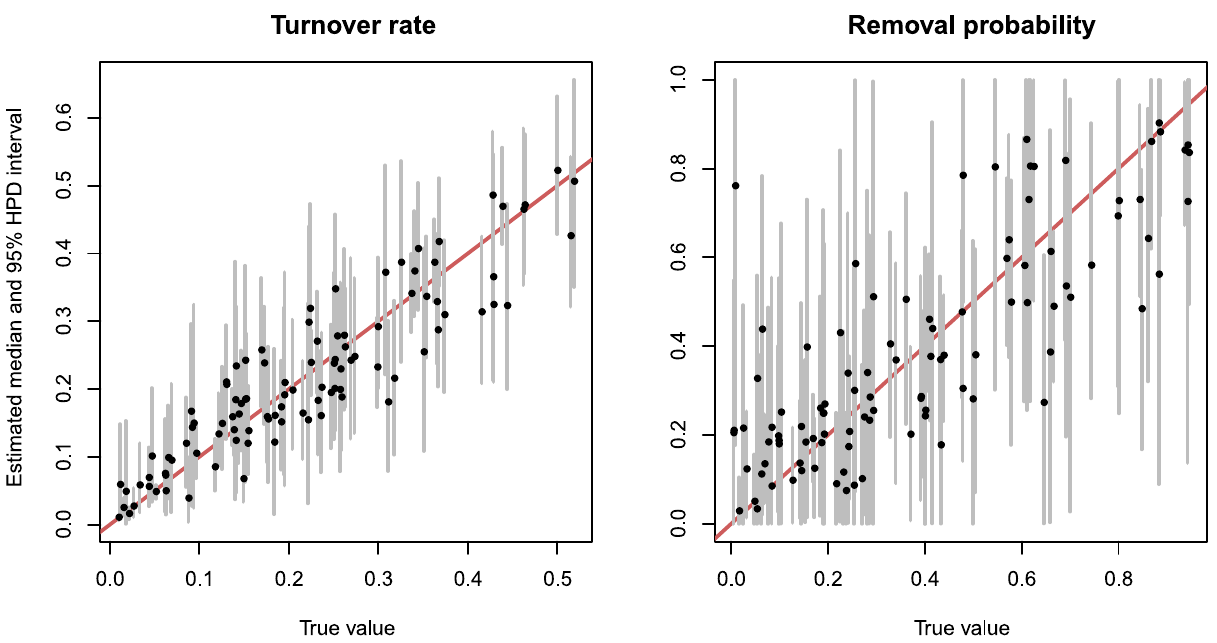
Figure 5. Parameter estimates for simulated data (transmission process). The graph shows median estimates (black dots) and 95% HPD intervals (grey lines) against true values for the turnover rate, n , (on the left) and removal probability, r , (on the right).